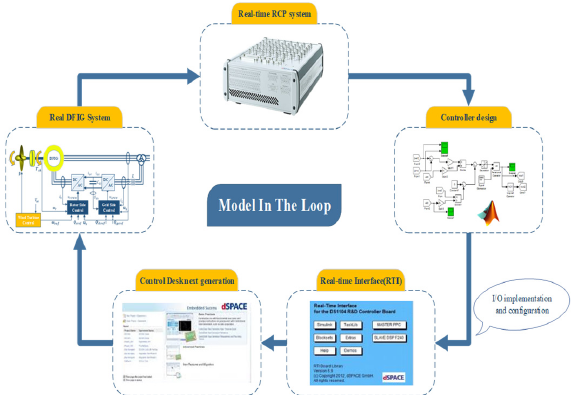
Figure 9. Overall scheme of the real-time MiL platform.